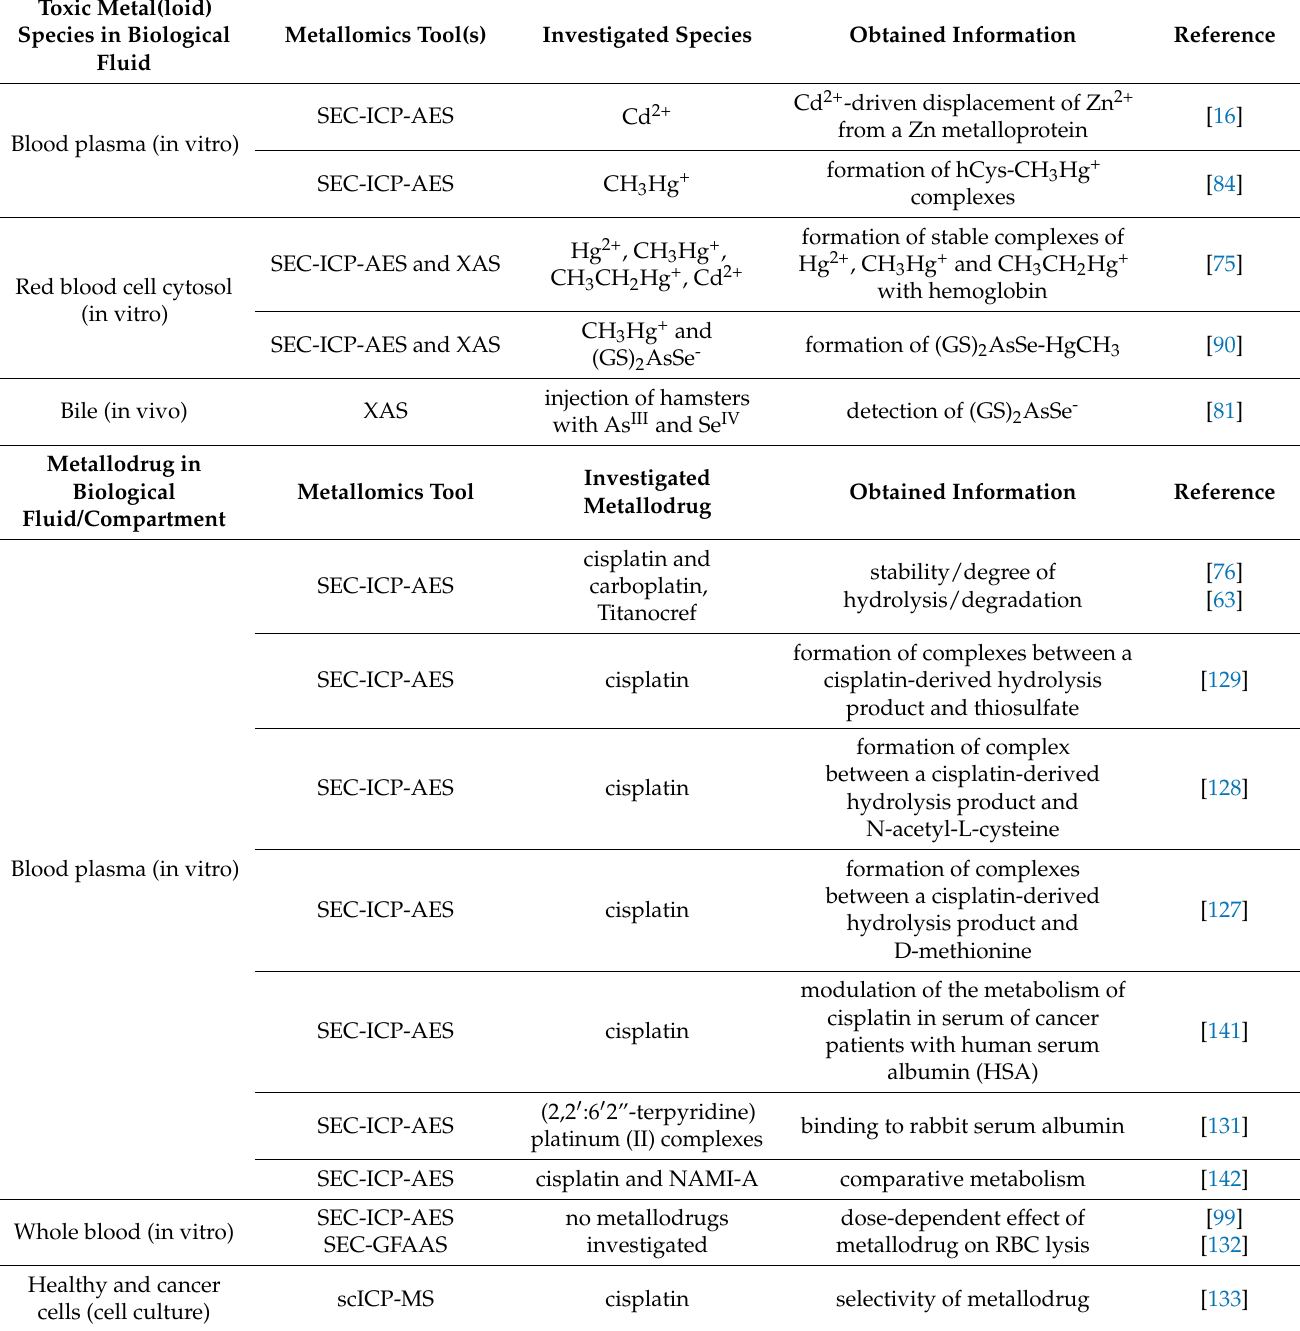
Table 3. Overview of studies which exemplify the usefulness of different metallomics tools to probe the interaction of toxic metal(loid) substances with different biological fluids and/or